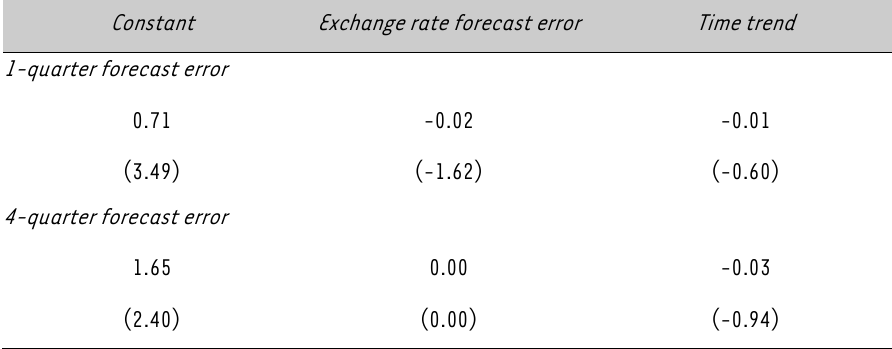
TABLE 8: Inflation forecast errors and exchange rate (rand/dollar) forecast errors, 2000-2006